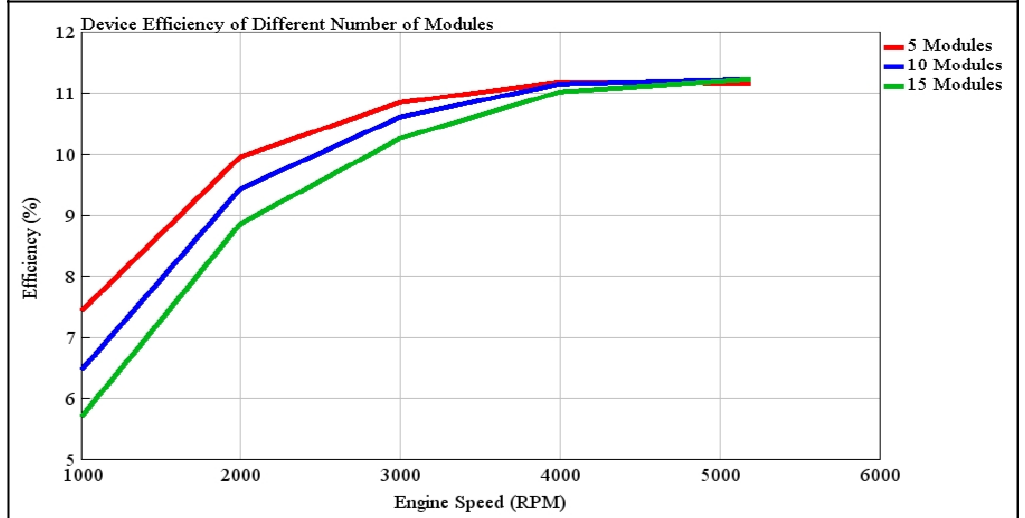
Figure 21. Average power generated by TEG at different engine speed (25 mm ×25 mm).